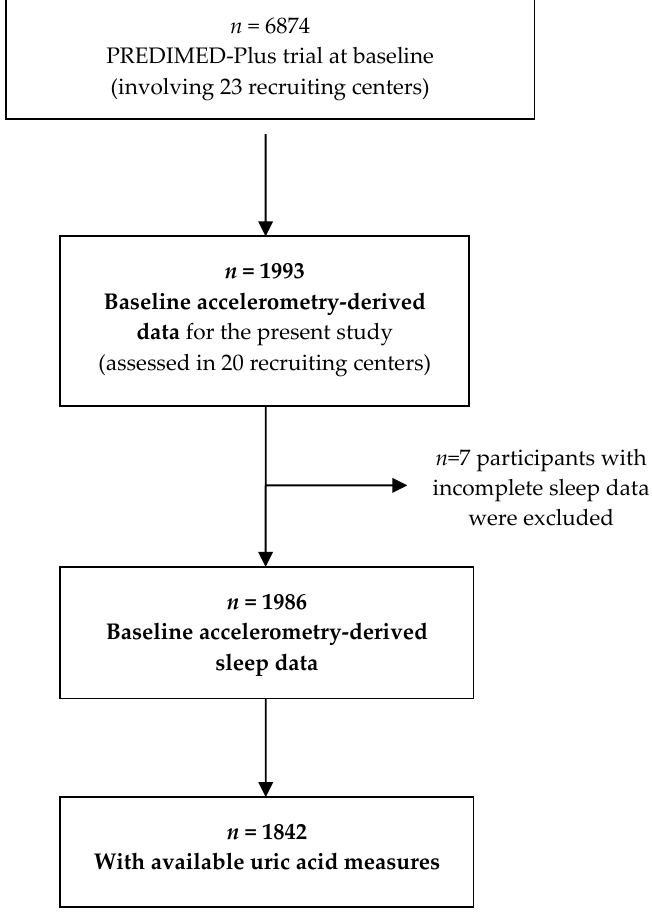
Figure 1. Flow-chart of study participants.